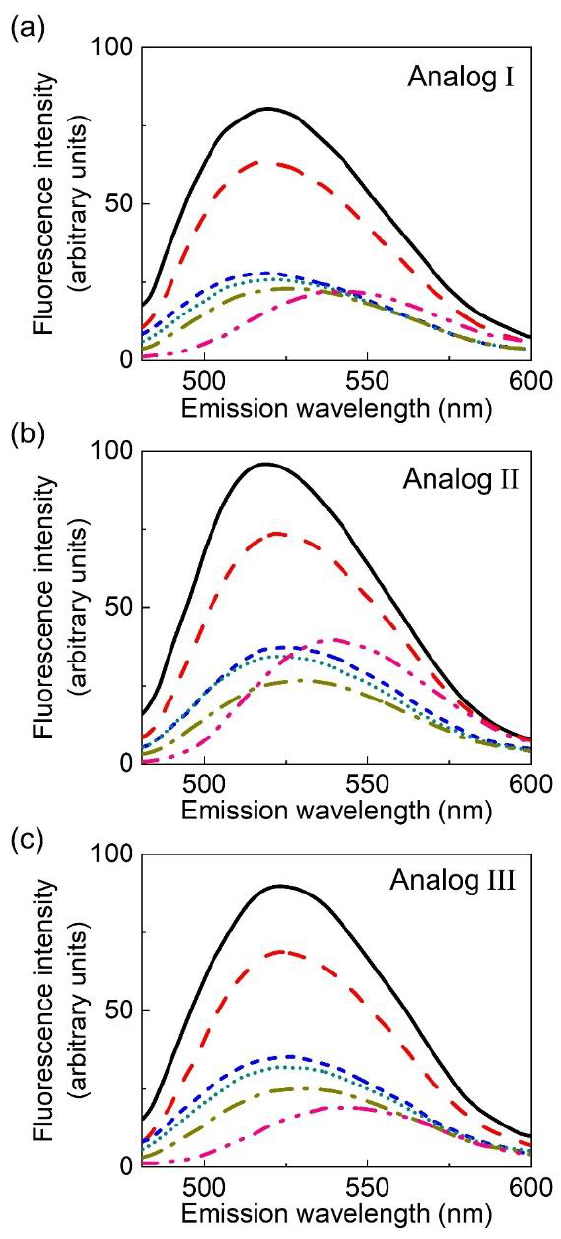
Figure 3. Fluorescence emission spectra of NBD-labeled analogs of serotonin (I–III) in solvents of varying polarity shown in panels ( a – c ), respectively. The solvents used were tetrahydrofuran ( — ), acetone ( —— ), isopropanol ( — ), ethanol ( ...... ), methanol ( ——- ), and dimethyl sulfoxide ( —- —- ). The concentration of the NBD analogs of serotonin used was 8 µ M and the excitation wavelength used was 465 nm in all cases. See Materials and Methods for other